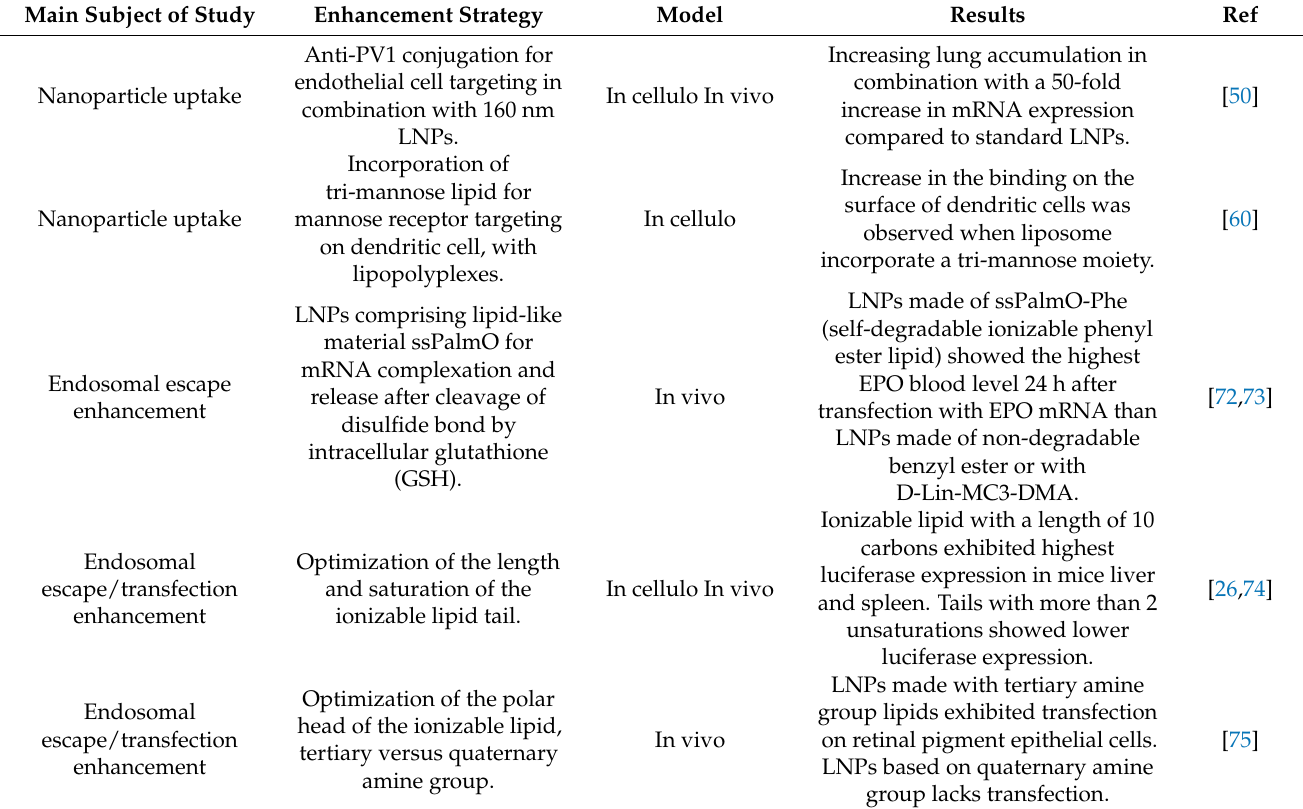
Table 1. Summarizing table of the different lipidic formulation reported in this